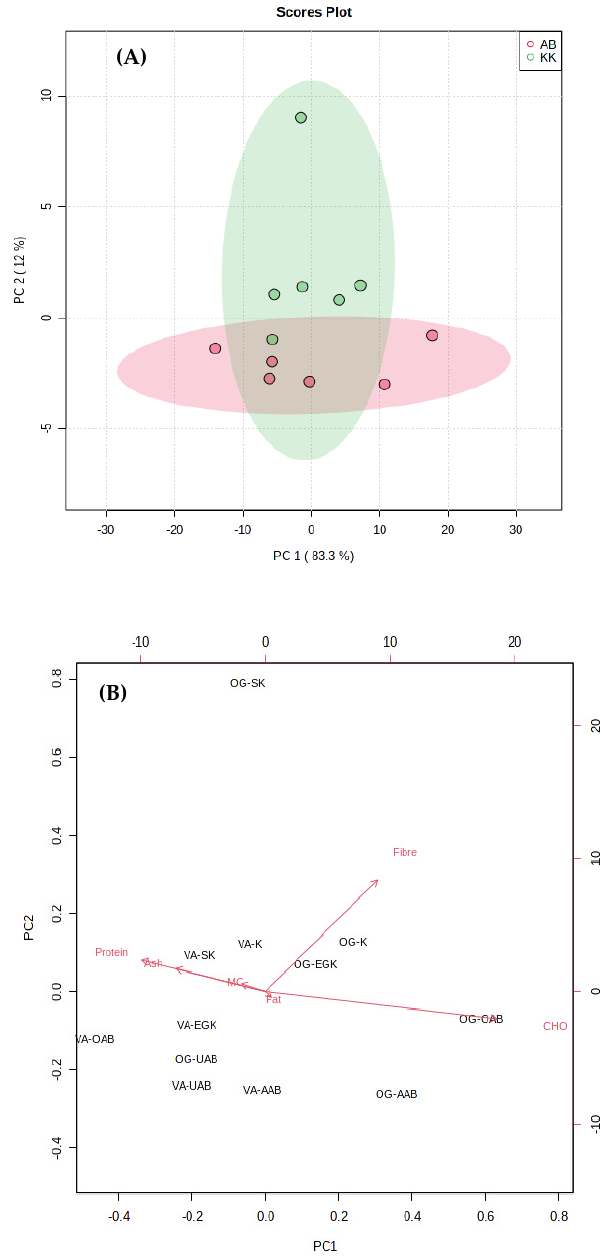
Figure 2. ( A ) PCA scores for the proximate composition of VA and OG collected from crude oil ‐ spill Kokori and crude oil ‐ free Abraka communities. Green circles correspond to vegetables from crude oil spill areas (Kokori). Pink circles correspond to vegetables from crude oil ‐ free areas (Abraka). ( B ) Biplot based on principal component analysis of VA and OG chemical composition and species arrangement.